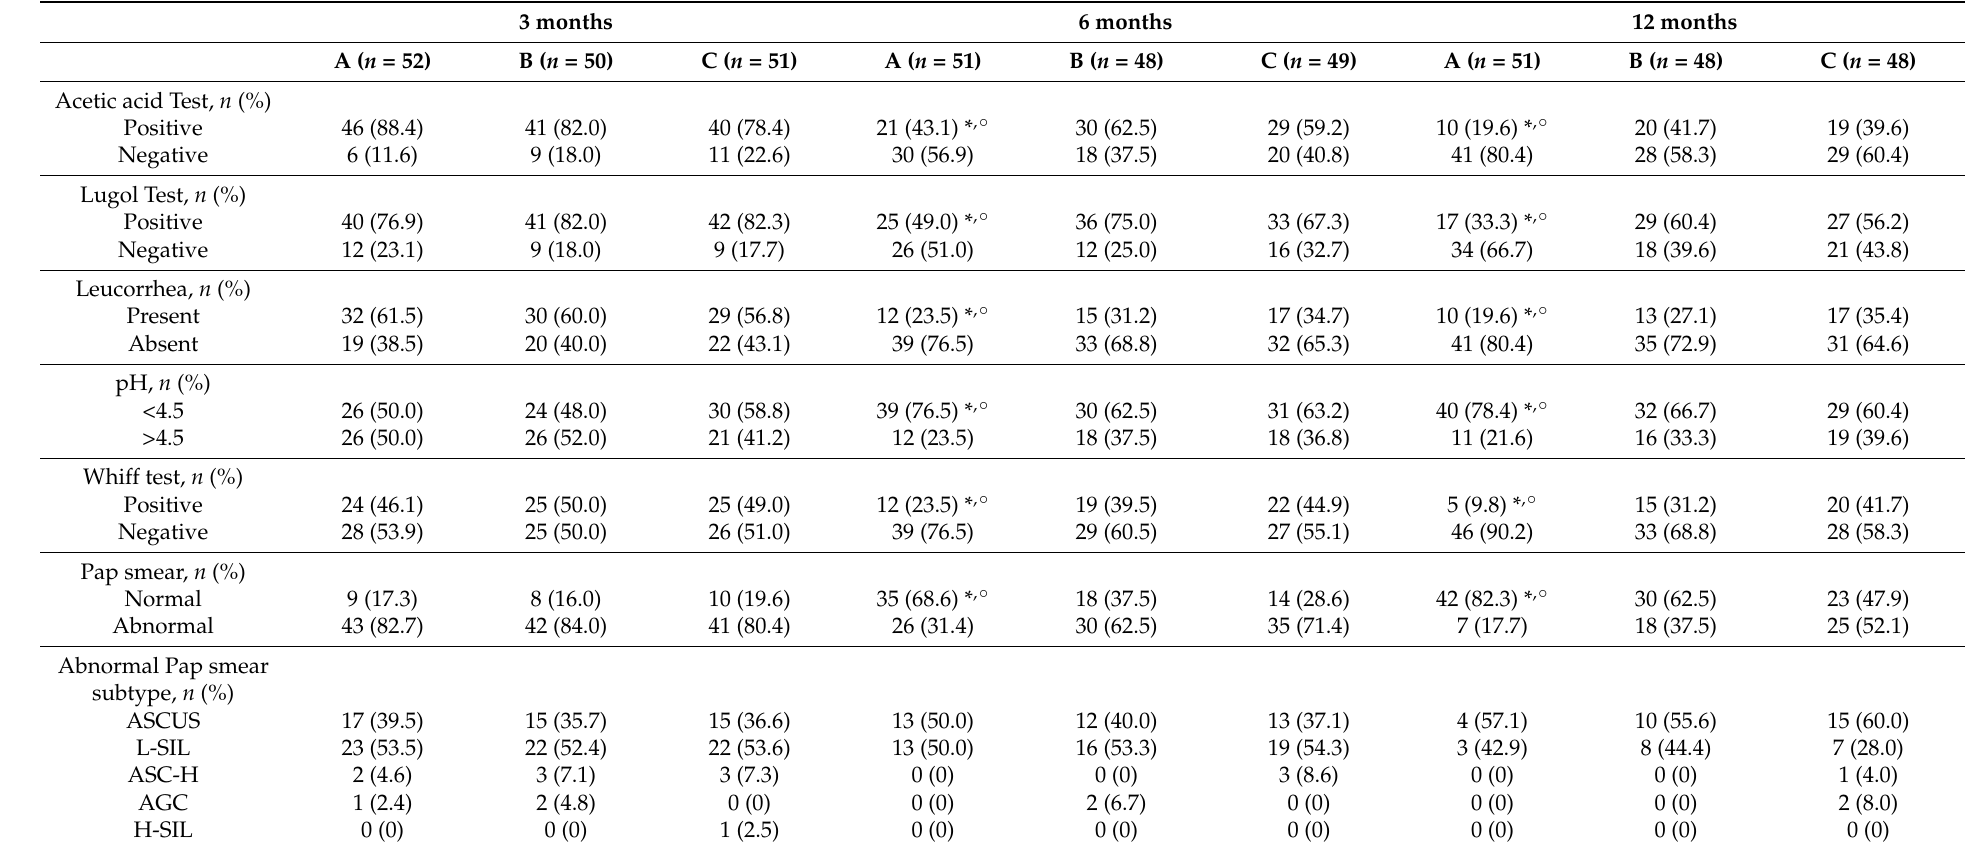
Table 3. Colposcopic, vaginal and cytologic outcomes at 3-, 6- and 12-months